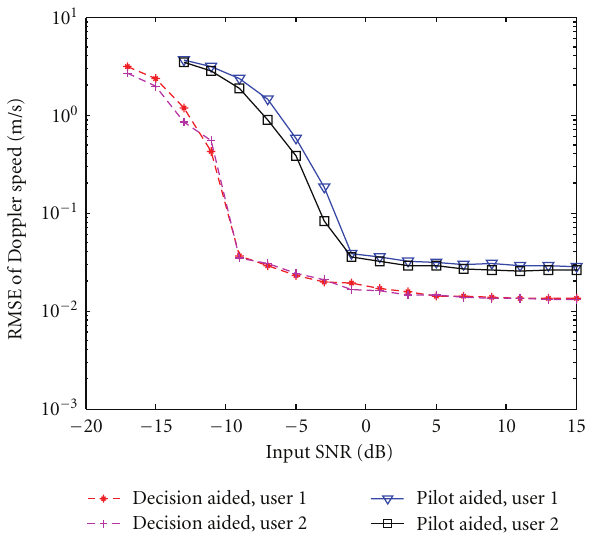
Figure 12: Pilot- and decision-aided Doppler scale estimation in a distributed two-user ZP-OFDM